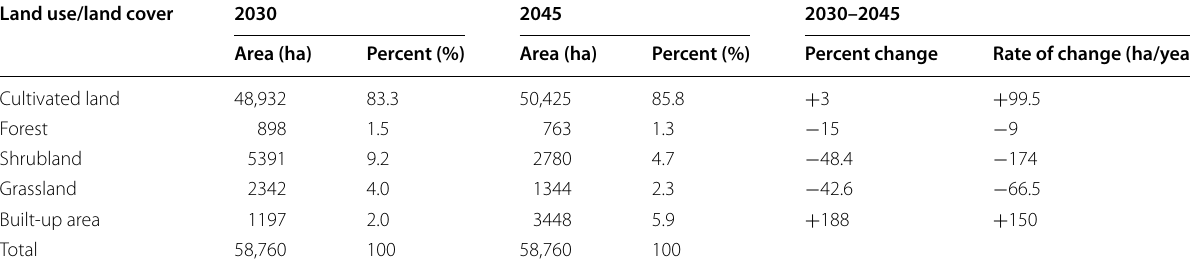
Table 11 The projected LU/LC area in 2030 and 2045 in the Andassa watershed Land use/land cover